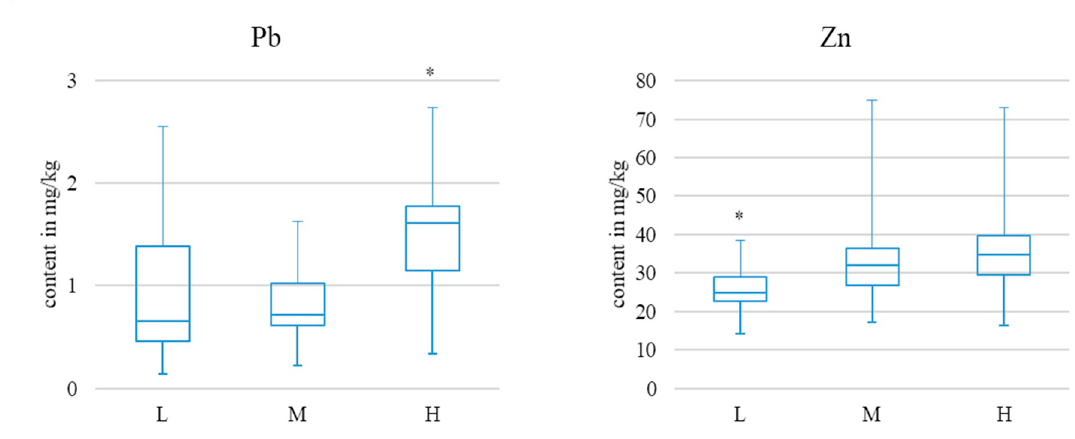
Figure 5. Box-and-whisker plots for selected elements Ba, Na as examples for notbeing statistically different; K, Li, Mg, and Sr being different between all sampling sites; Pb and Zn being different at one site. (L = low traffic volume; M = medium traffic volume; H = high traffic volume). *—statistically significant difference. Table 3. Mean elemental contents in mg/kg (elements with statistically significant differences be- tween fresh shoots and one-year-old needles (1a) are written in italic) alongside trend ( ↑ —increasing; ↓